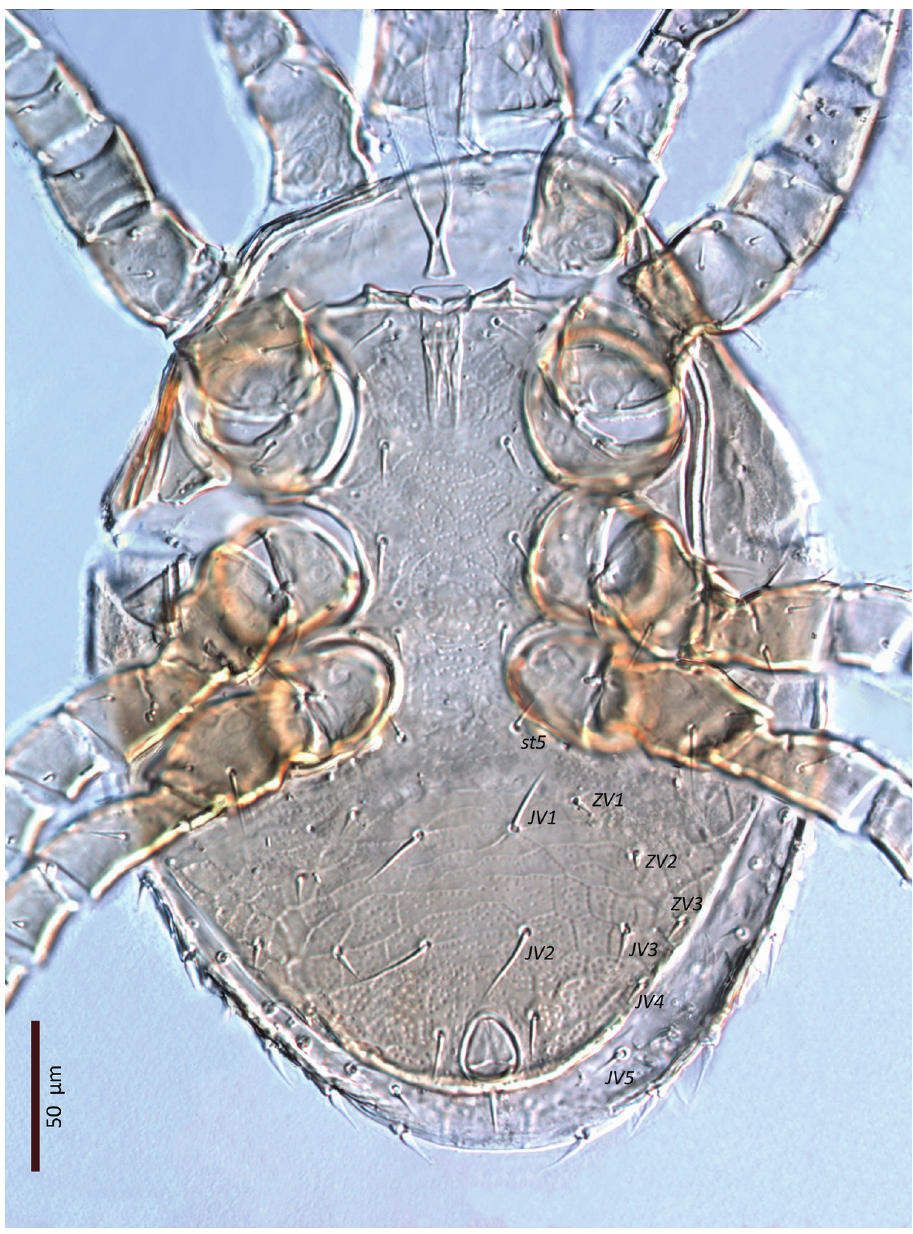
Figure 31. Zygoseius papaver sp. n., male, ventral